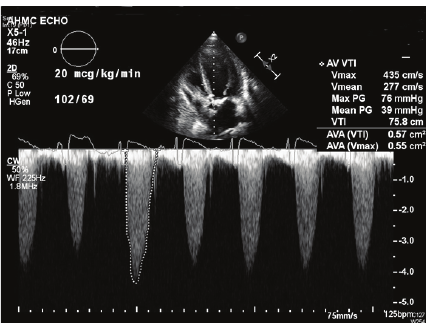
Figure 1: Dobutamine stress echocardiogram (DSE) at 20 mcg/kg/ min of dobutamine. AVA: aortic valve area, HGen: midrange fre- quency, PG: pressure gradient, Vmax maximum velocity, Vmean: mean velocity, and VTI: velocity time integral.